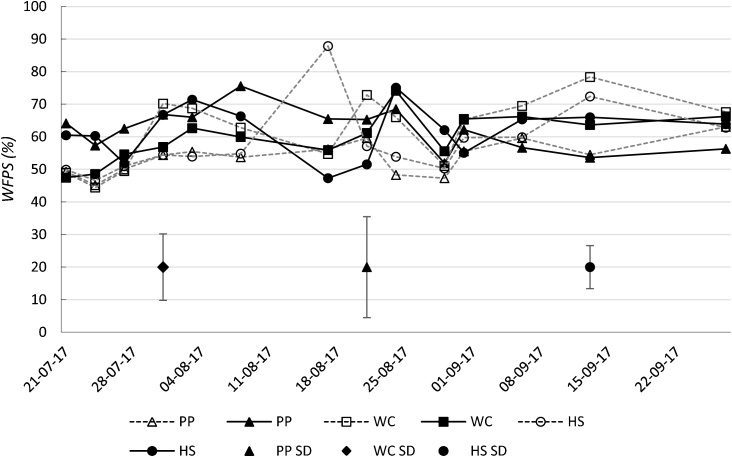
Water filled pore space (WFPS) (as % fresh soil) from designated moisture controls and dung plots on each farmlet. Results presented are post-treatment. Error bars represent the average standard deviation (SD) across all treatments. PP = permanent pasture; WC = white clover/high sugar grass mixed sward; HS = high sugar grass monoculture.